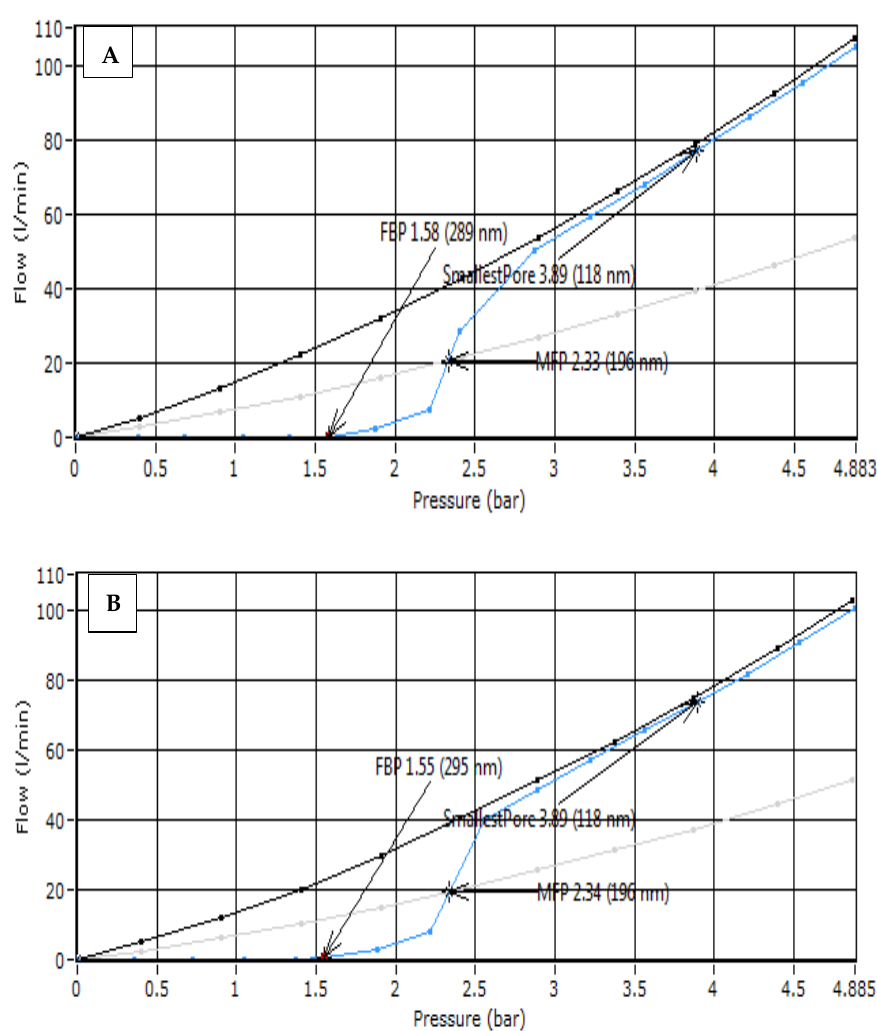
Figure 2. Capillary Flow Porometry (bubble point) method for: ( A ) new polytetrafluoroethylene (PTFE) membrane, ( B ) used PTFE membrane at feed temperature = 70 °C and initial boron concentrations 30 ppm.